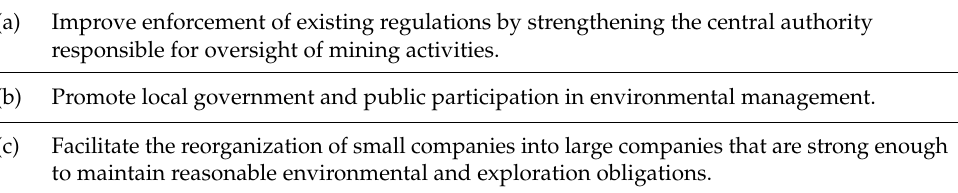
Table 7. Suggested measures to improve the ASLGM in the Ecuadorian